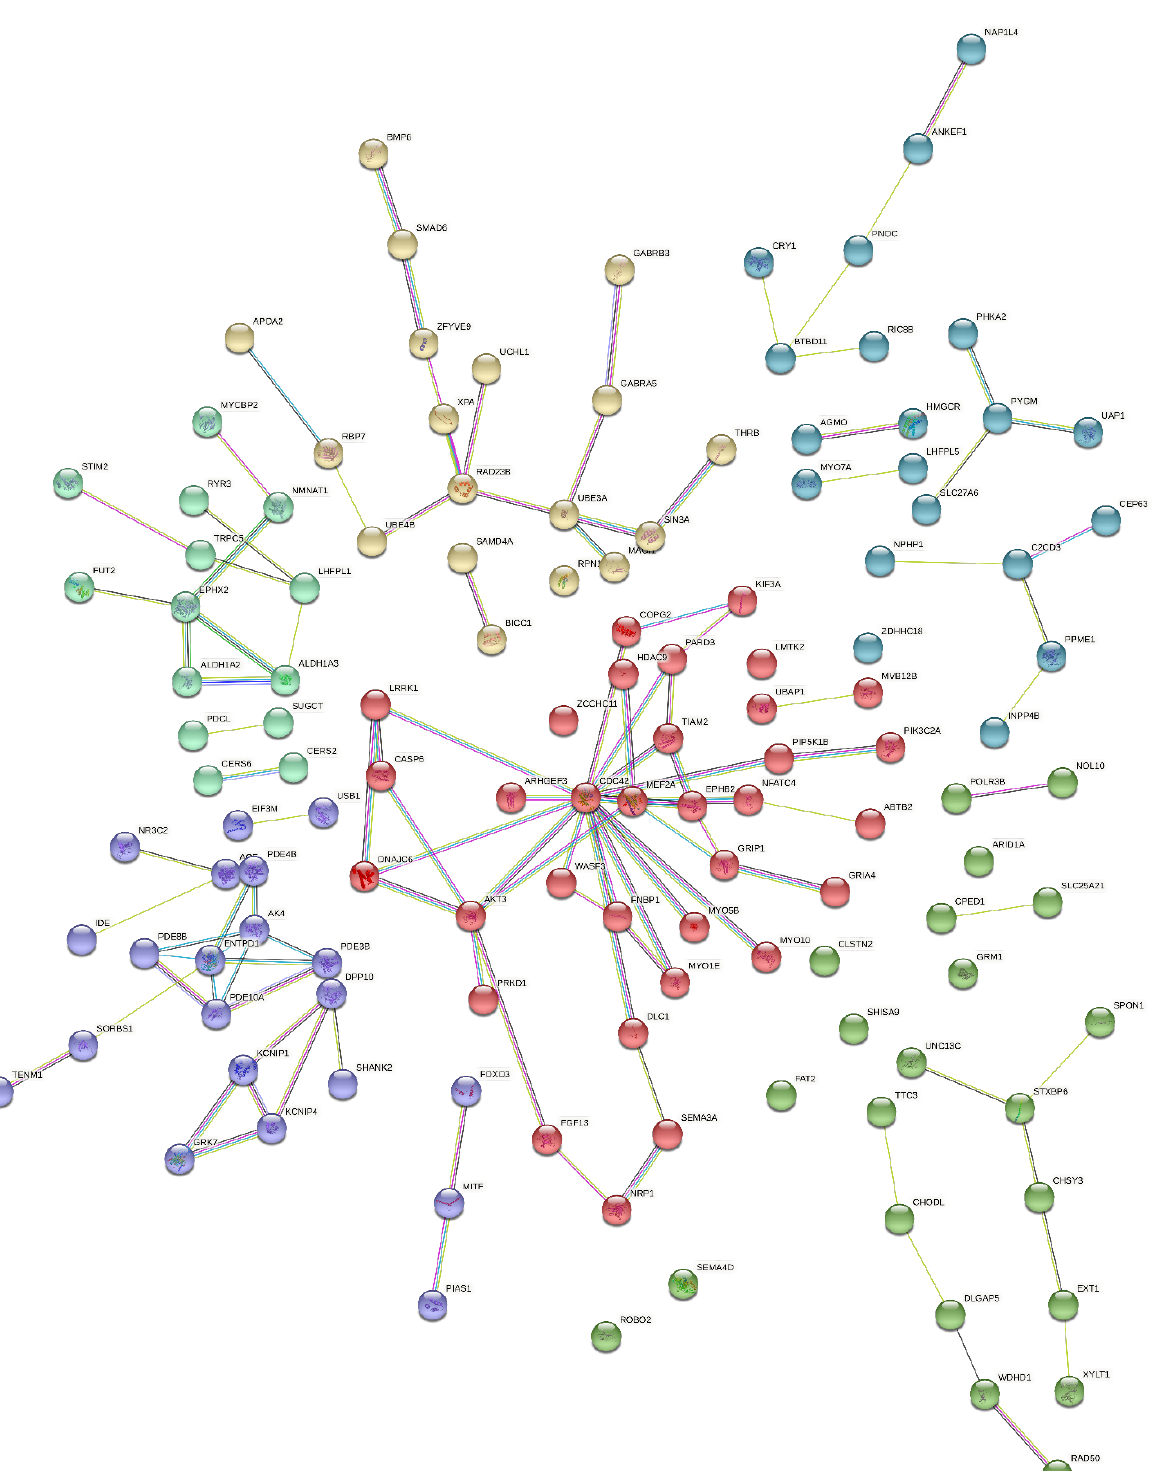
Figure 3. Protein–protein interaction network analysis of genes associated with total number born, number born alive, number of stillborn, litter birth weight, and corpus luteum number in pigs. Types of interactions: teal line—known interaction based on curated database, pink line—known interaction experimentally determined, green line—predicted interaction based on gene neighborhood, red line—predicted interaction based on gene fusion, blue line—predicted interaction based on a gene co-occurrence.